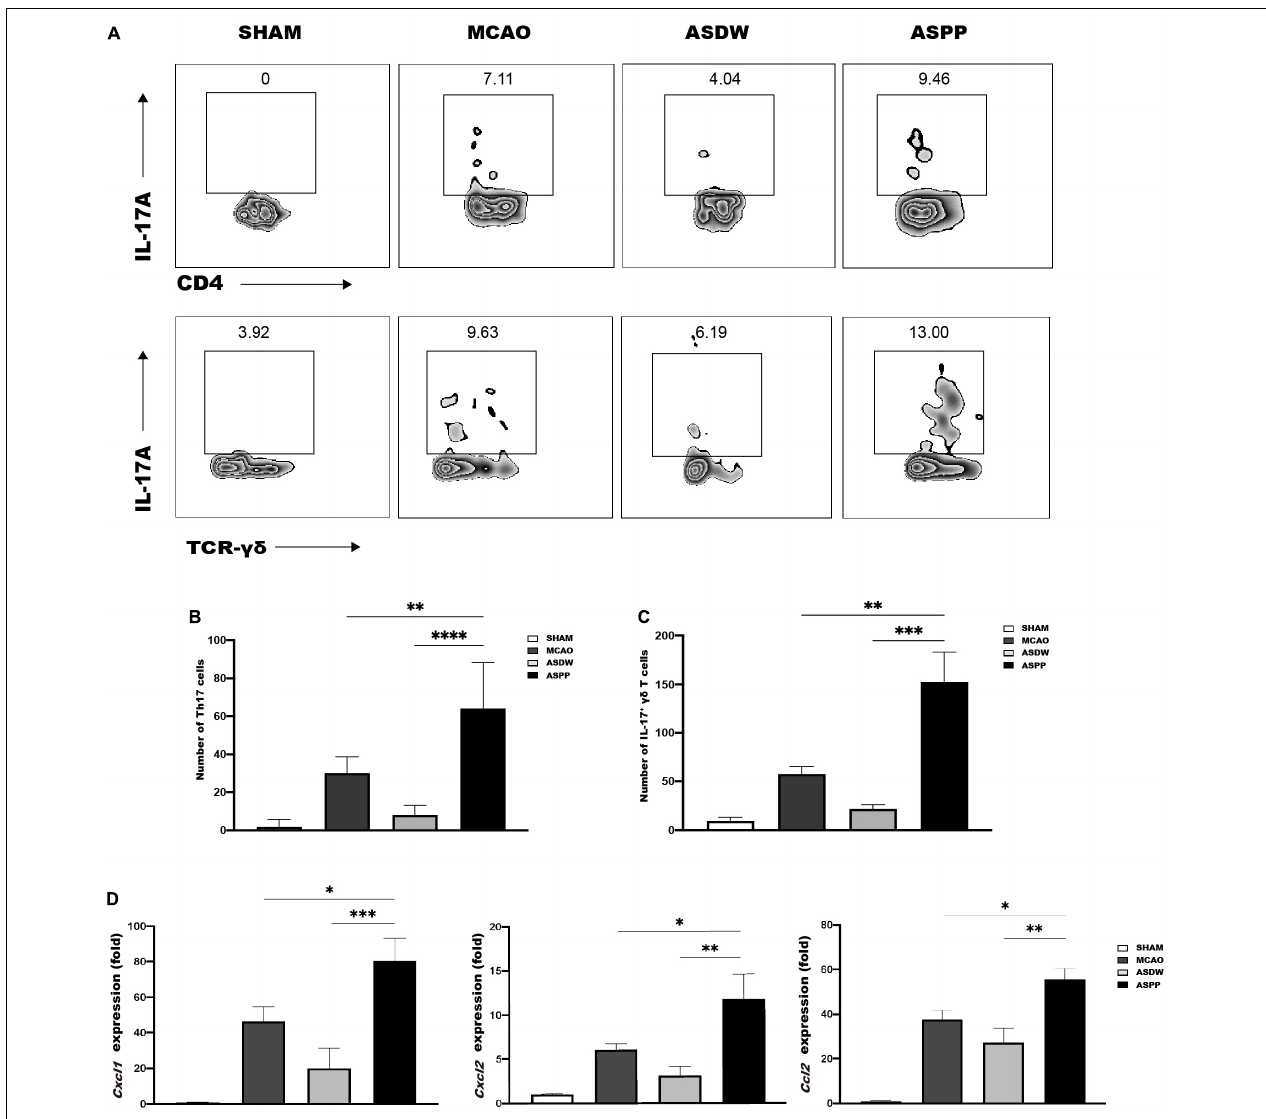
FIGURE 3 | More Th17 and IL-17 + γδ T cells accumulate in the ischemic brain of ASPP group. (A) Representative flow cytometry analysis of Th17 cells and IL-17 + γδ T cells in the ischemic brain. (B) Quantification of Th17 cells. n = 4:4:4:4. (C) Quantification of IL-17 + γδ T cells. n = 5:5:5:5. (D) qPCR analysis of relative mRNA expression of Cxcl1 , Cxcl2 , and Ccl2 in the ischemic brain. n = 7:10:8:10. Values represent mean ± SD . One-Way ANOVA was used for statistical analysis. ∗ p < 0.05, ∗∗ p < 0.01, ∗∗∗ p < 0.001, ∗∗∗∗ p <